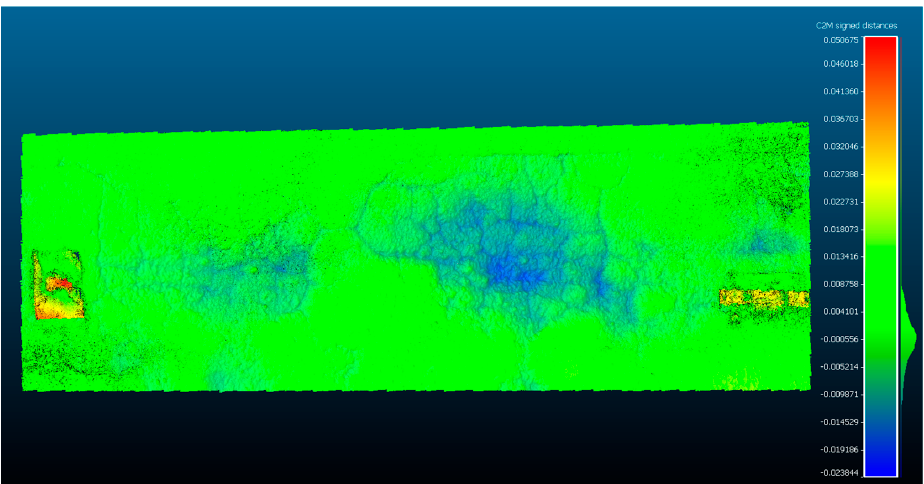
Figure 22. Pavement section 1 with the depth map created.